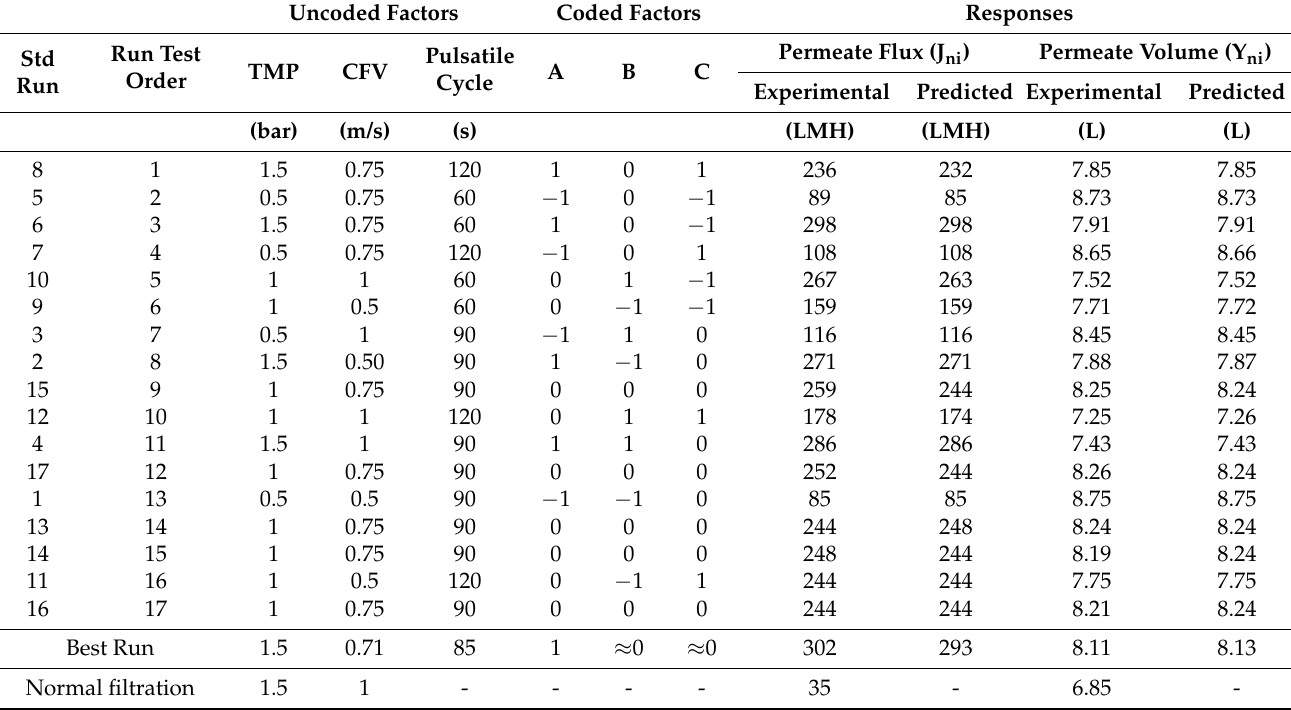
Table 7. Three Box–Behnken design factors and their corresponding responses. Uncoded Factors Coded